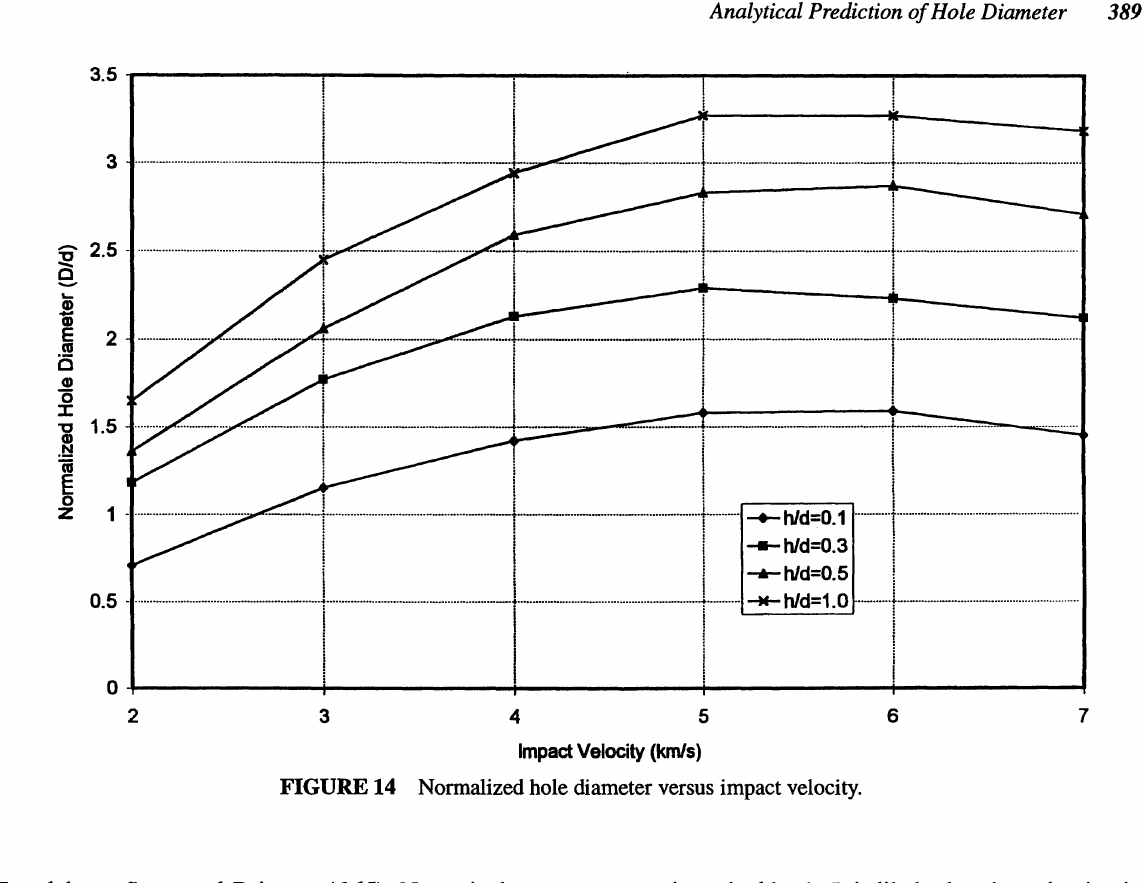
FIGURE 14 Normalized hole diameter versus impact